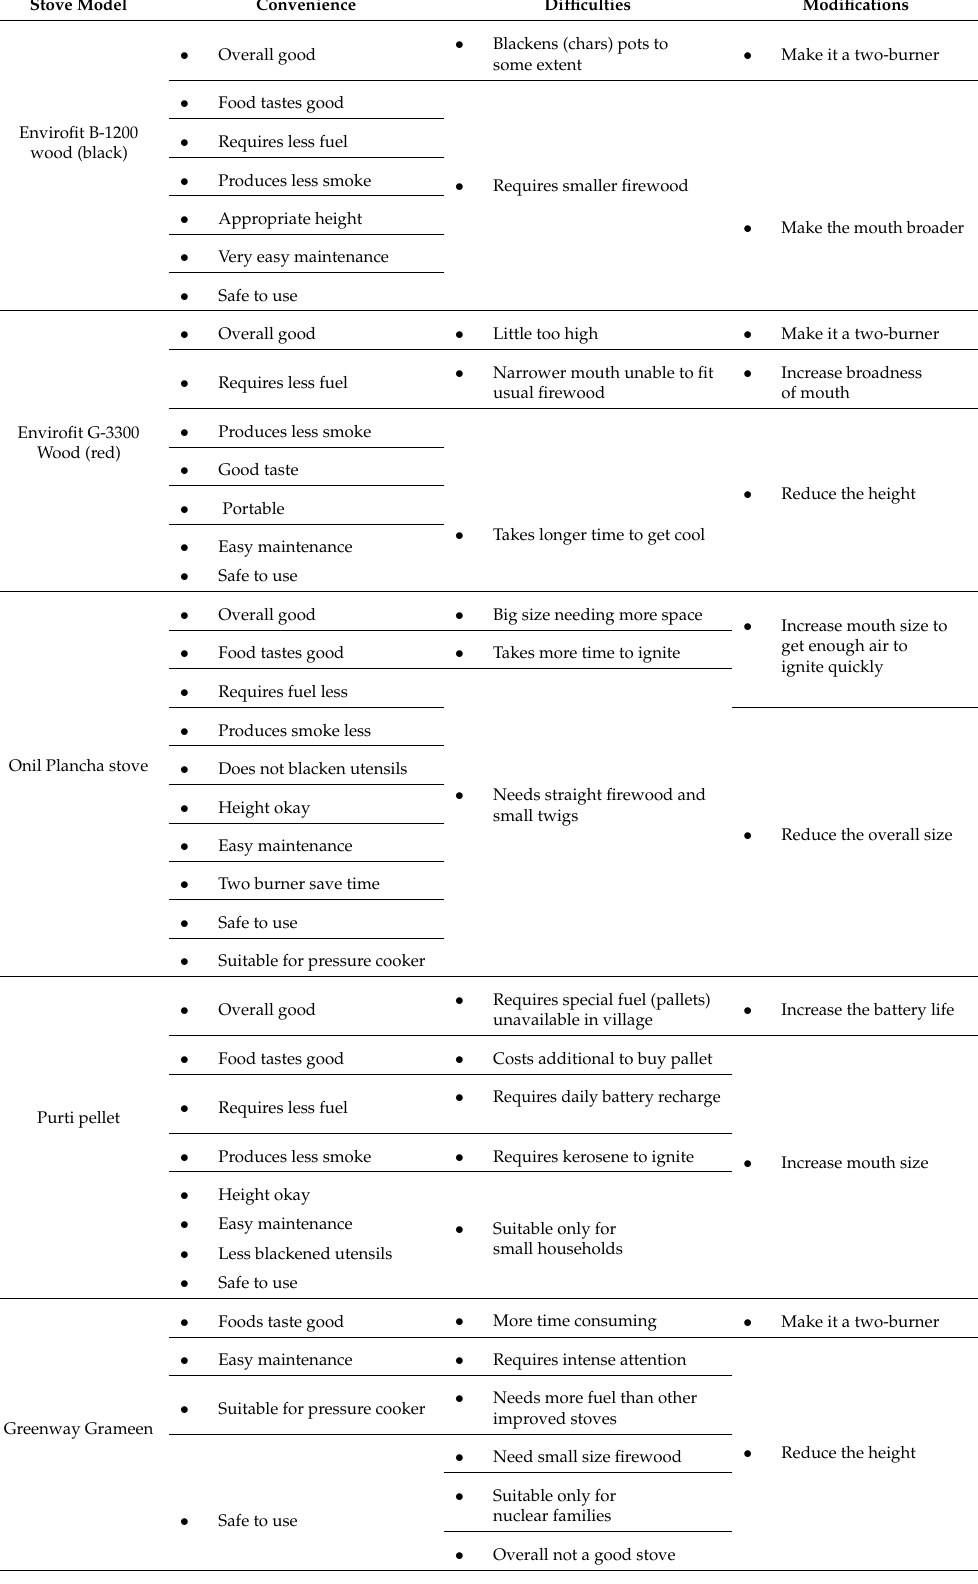
Table 3. Convenience, difficulties and suggested modifications from the improved cookstove (ICS) field test, by stove type, in rank order (top is highest